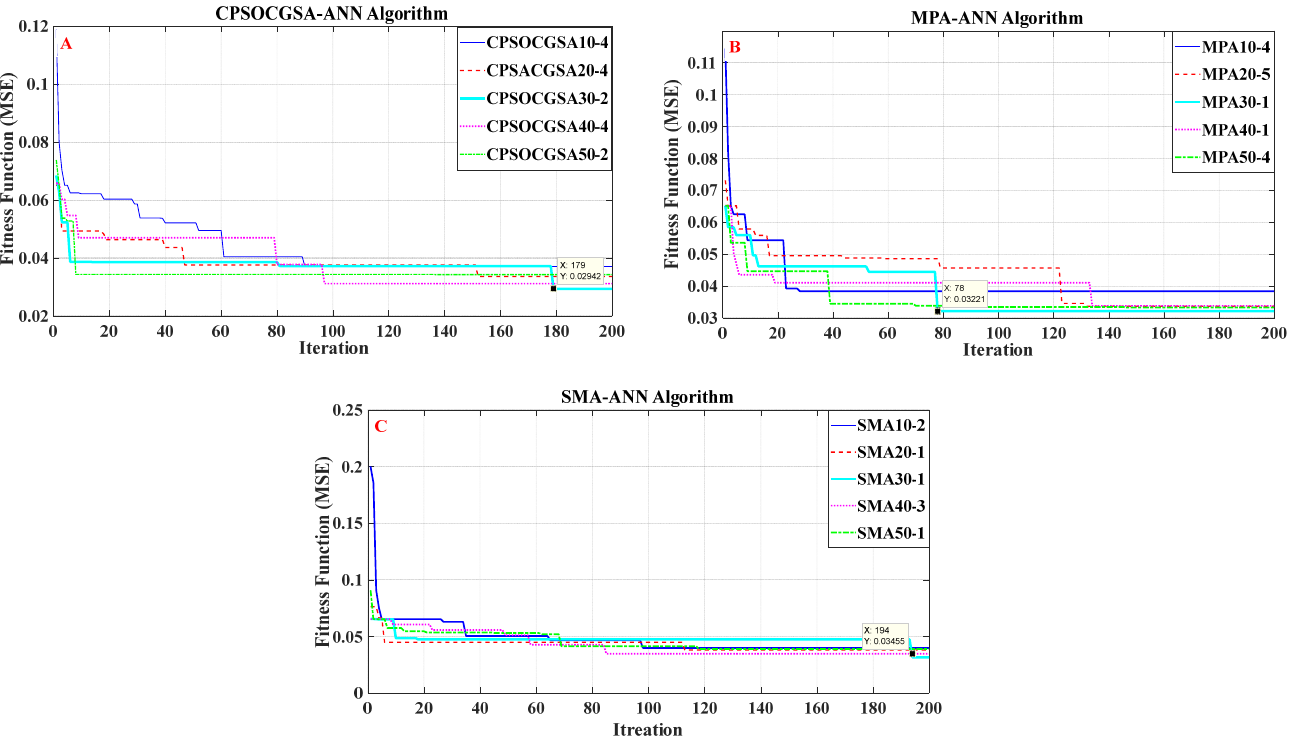
Figure 7. Fitness function of ( A ) CPSOCGSA-ANN algorithms, ( B ) MPA-ANN algorithms, and ( C ) SMA-ANN algorithms under five swarm